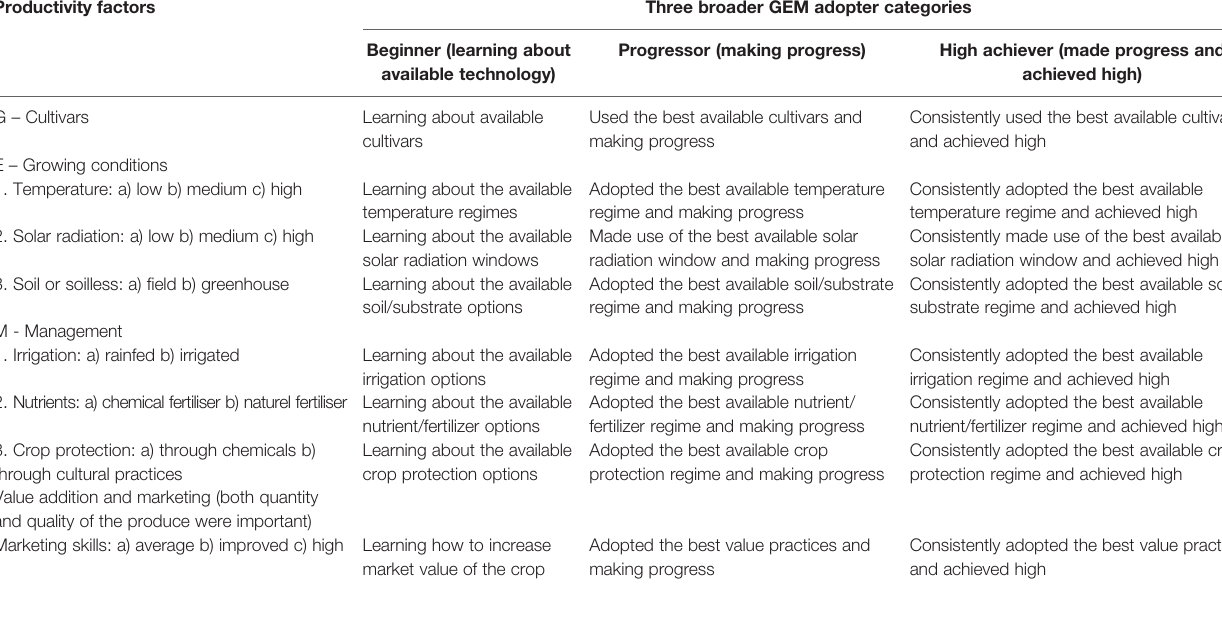
TABLE 1 | GEM adoption